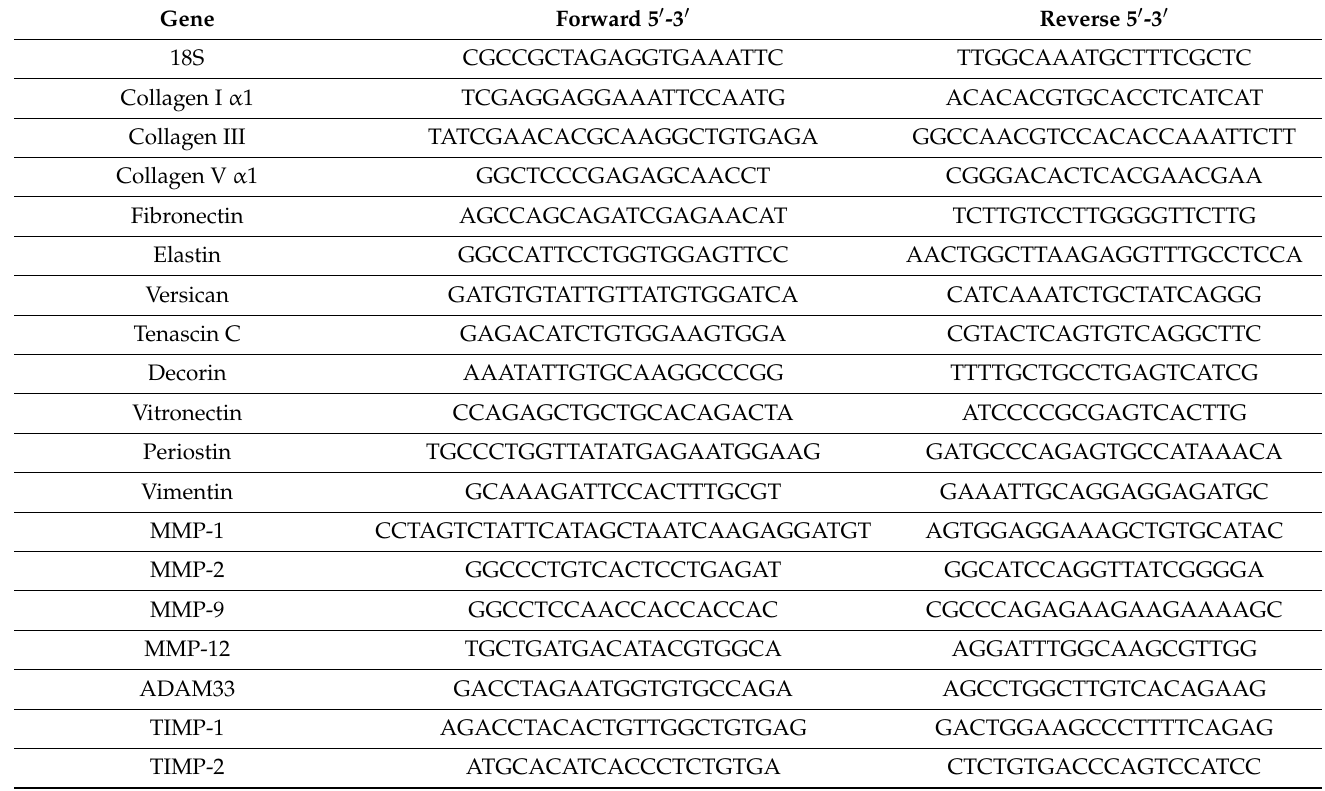
Table 3. Primers used for gene expression